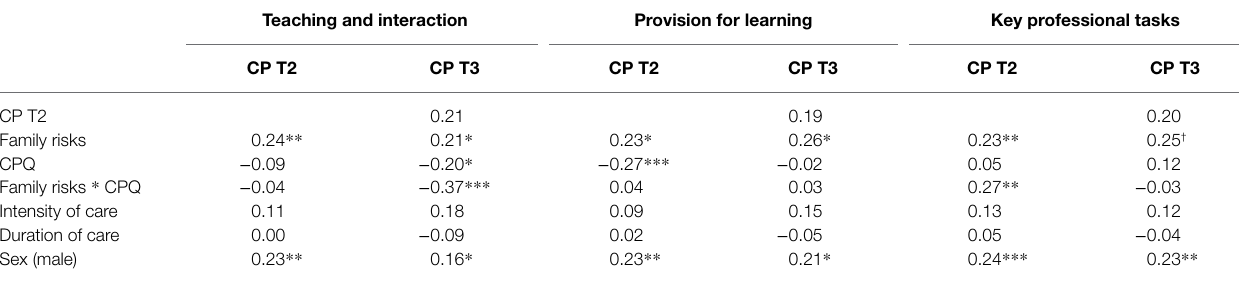
TABLE 4 | Standardized regression coefficients of the model for conduct problems ( N = 293). Teaching and interaction Provision for learning